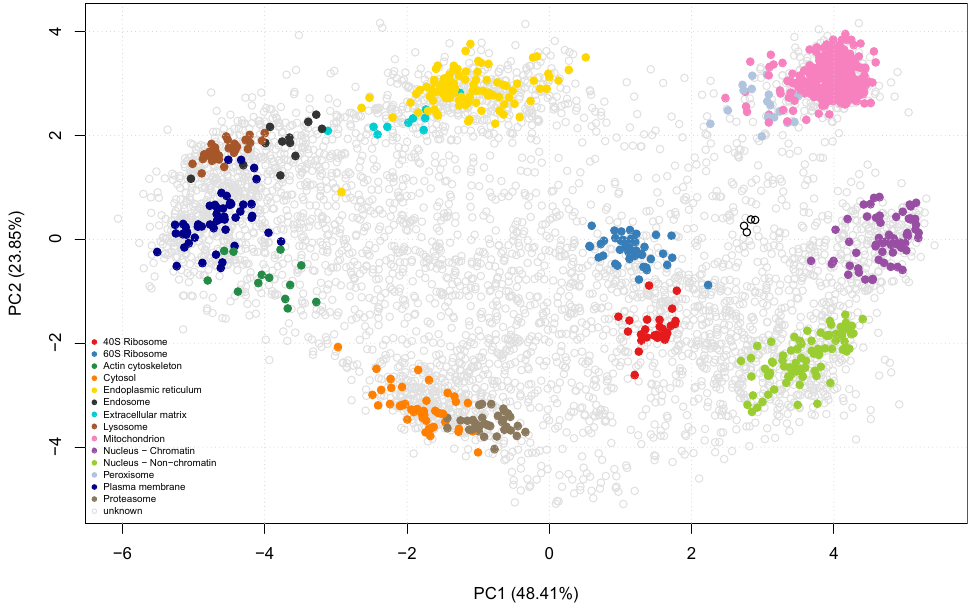
Figure 10. Highlighting protein features of interest.